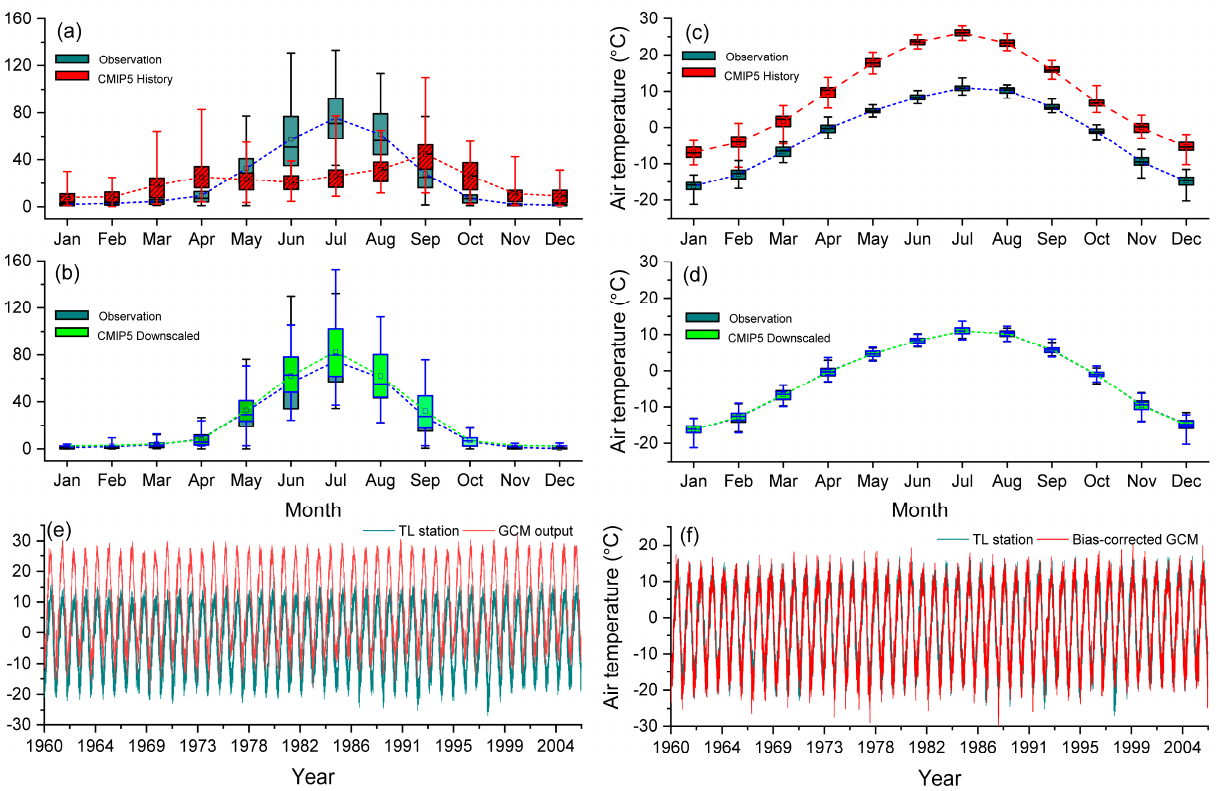
Figure 2. ( a , b ) Comparison of the monthly total precipitation for the raw GCM outputs, downscaled precipitation, and measurements of TL stations. ( c , d ) Comparison of the monthly mean precipitation for raw GCM outputs, observation, and the bias-corrected results. In the box-and-whisker plots, the centerlines represent the ensemble means, box limits indicate the 25th and 75th percentiles, and whiskers denote minimum and maximum values of the ensemble of 31 ensembles of GCM outputs. ( e , f ) Comparison of the mean daily air temperature for observation, raw GCM, and the bias-corrected GCM results.